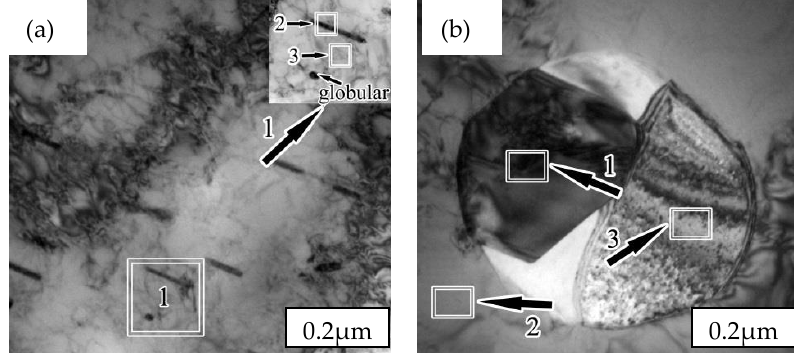
Figure 4. TEM images of samples after aging at 750 and 850 C: a ) SX-750; b ) SX-850.